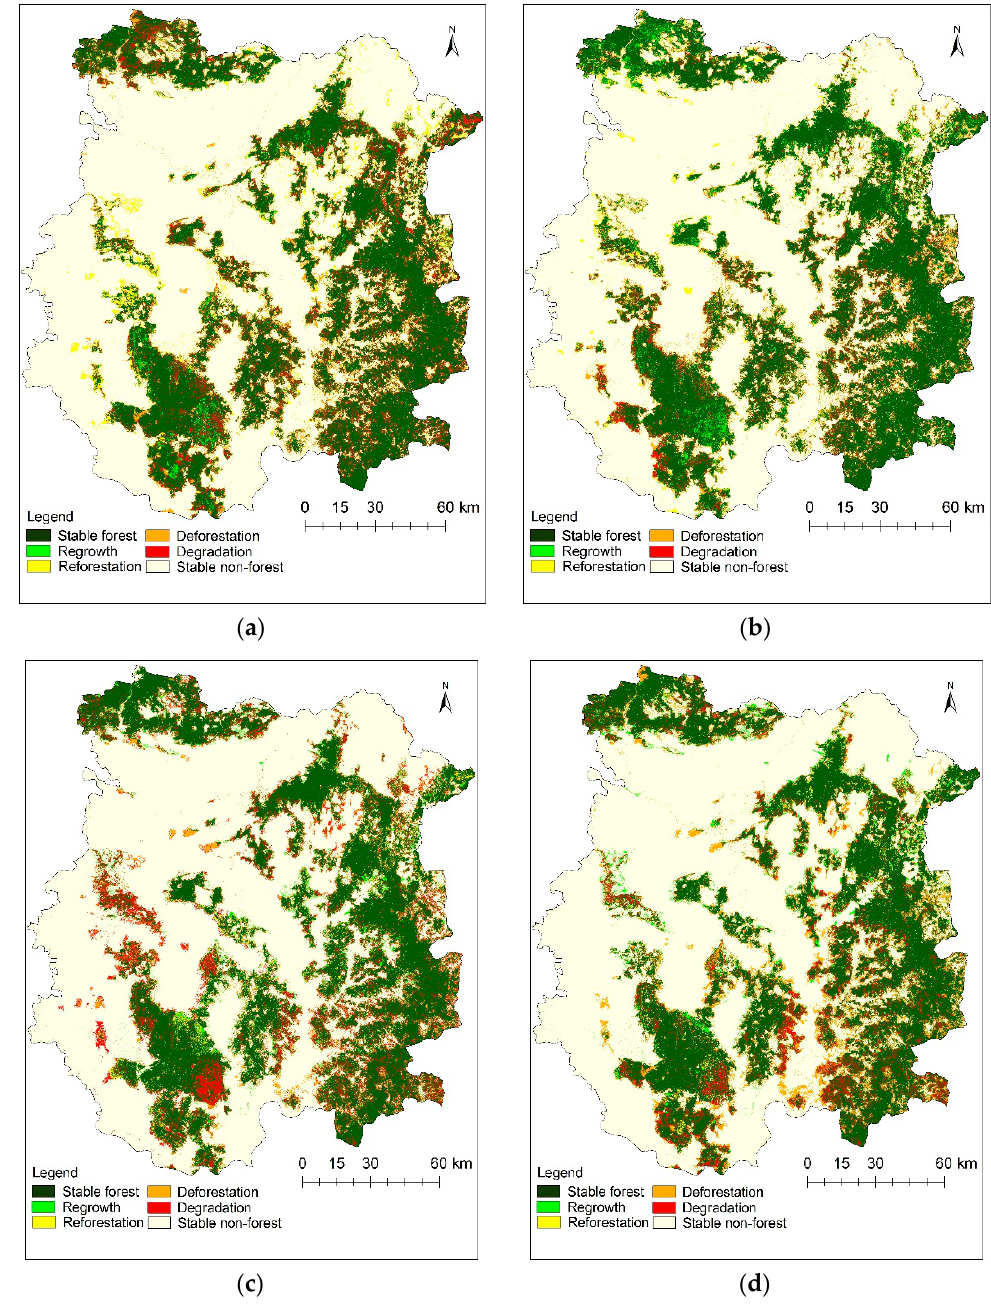
Figure 5. Forest change between ( a ) 1977–1990; ( b ) 1990–1999; ( c ) 1999–2011 and ( d ) 1977–2011. Table 5. Change in forest cover percentage over time across different management regimes.